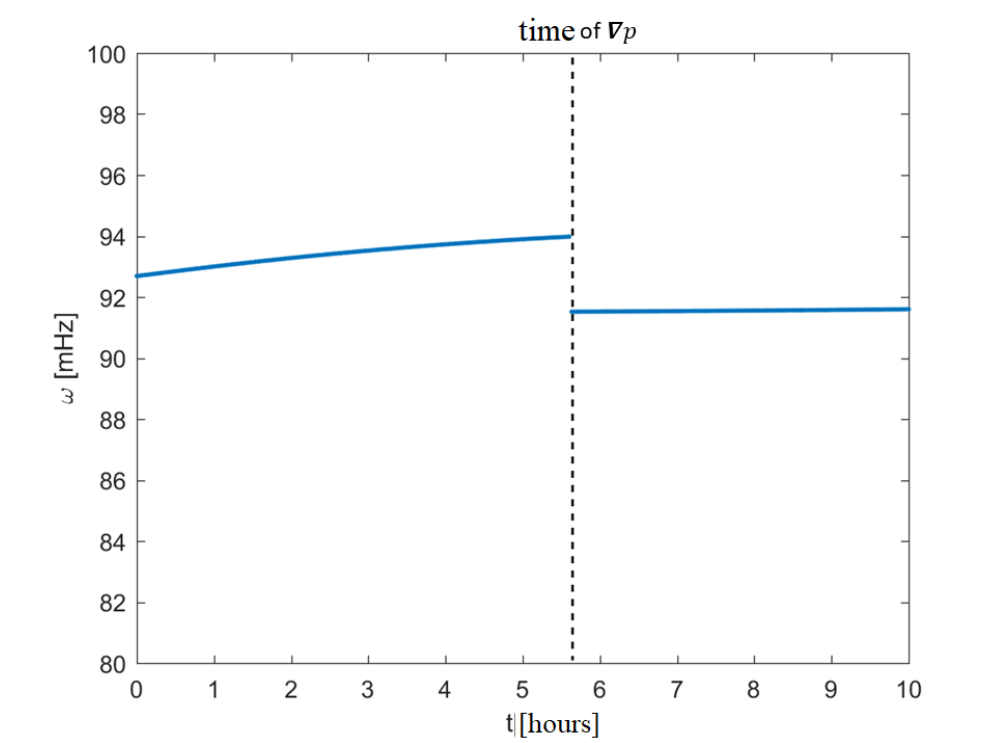
Figure 11. Behavior of the FLR eigen-frequency as modeled by an atmospheric pressure gradient caused by a seismic